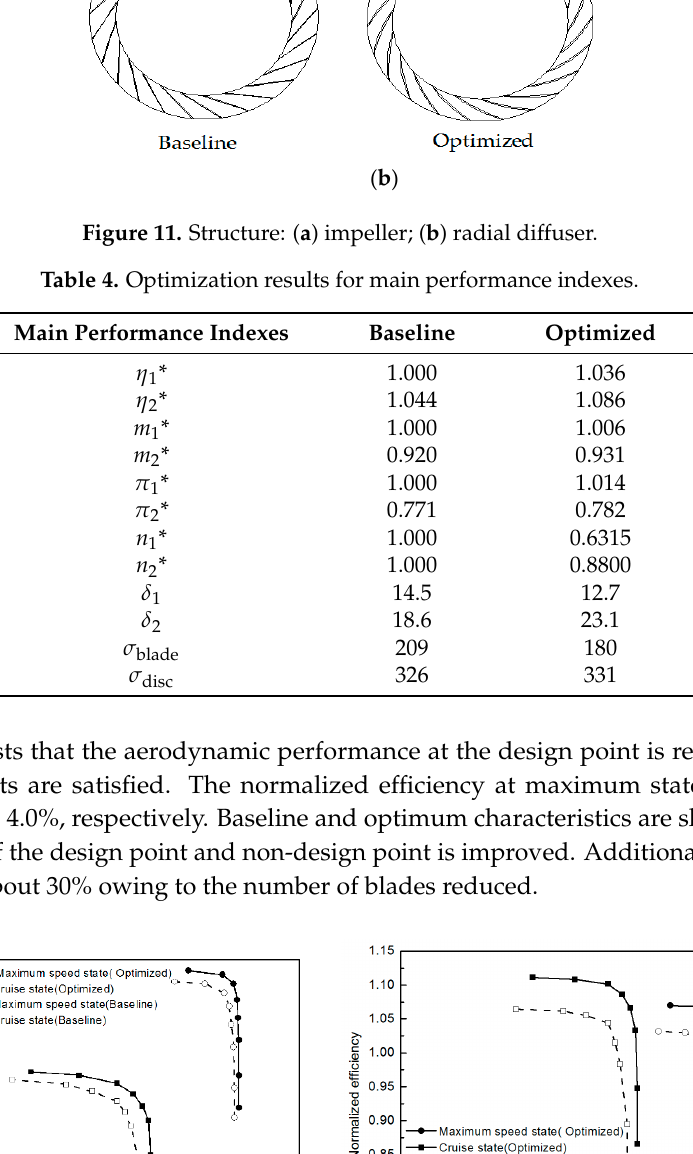
Figure 12. Baseline and optimum characteristics: ( a ) diagram of normalized pressure ratio with respect to normalized mass flow; ( b ) diagram of normalized efficiency with respect to normalized mass flow.